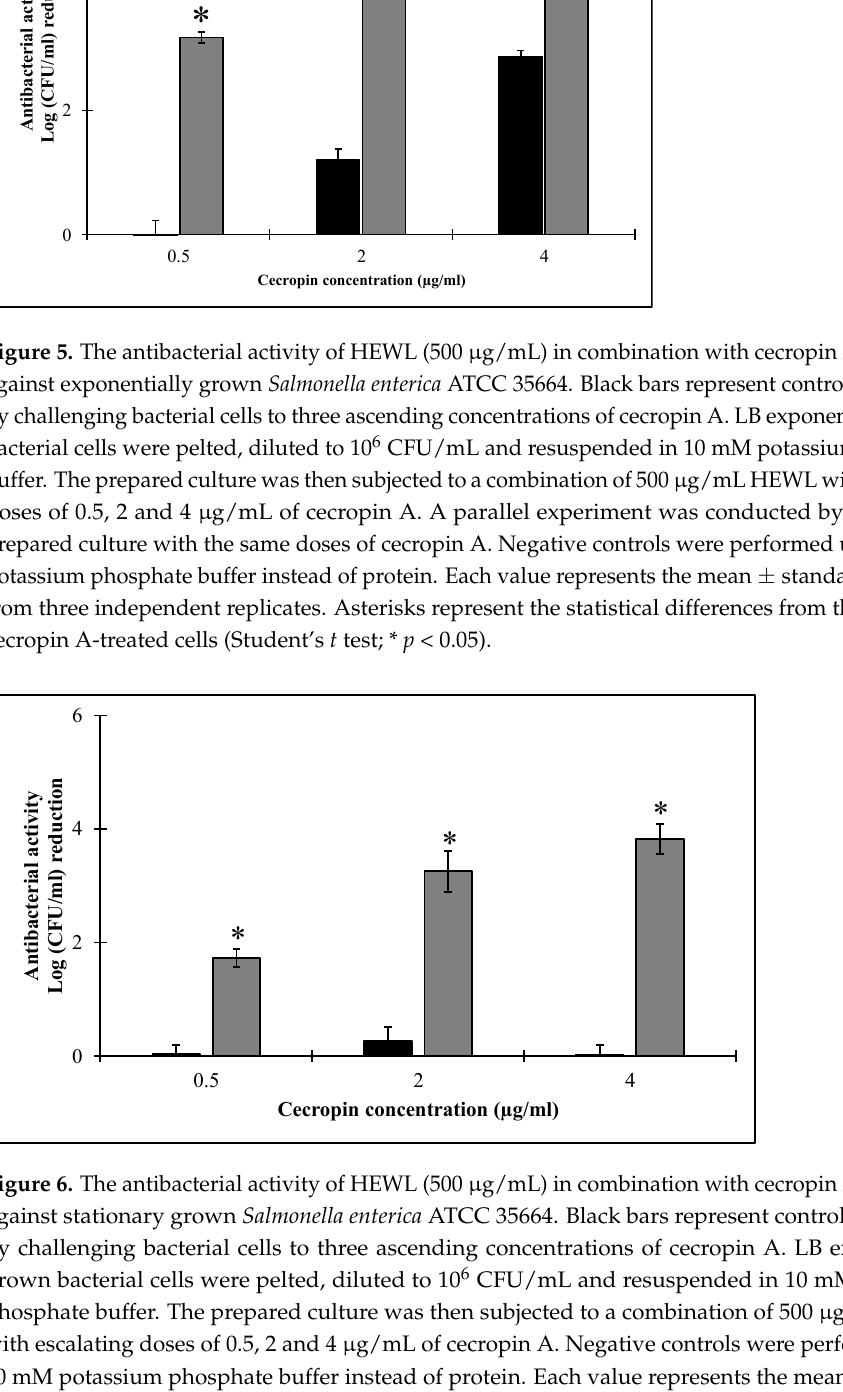
Cecropin concentration (µg/ml)